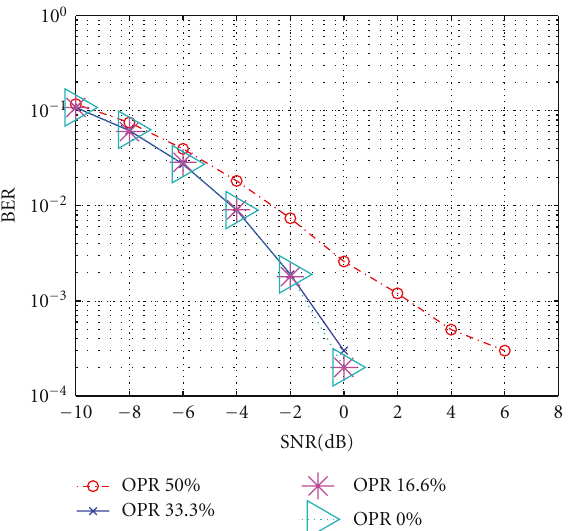
Figure 6: BER versus SNR for Hermite-Gaussian signals with zero to three order.